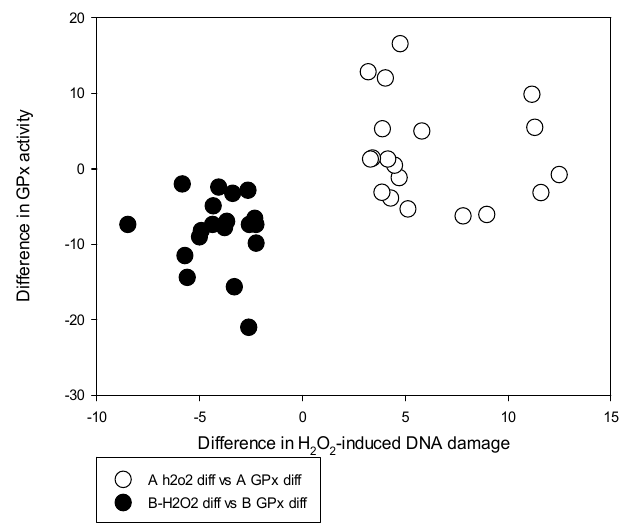
Figure 1. Distribution of individual differences of the GPx activity levels against difference in the H 2 O 2 -induced DNA damage levels among Groups A and B between baseline and post-supplemented time points.